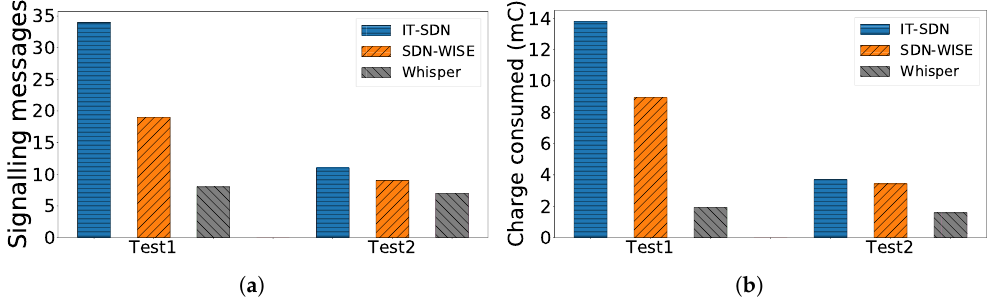
Figure 8. Overall signalling messages sent and charge consumed only for signalling related with routing in each of the compared